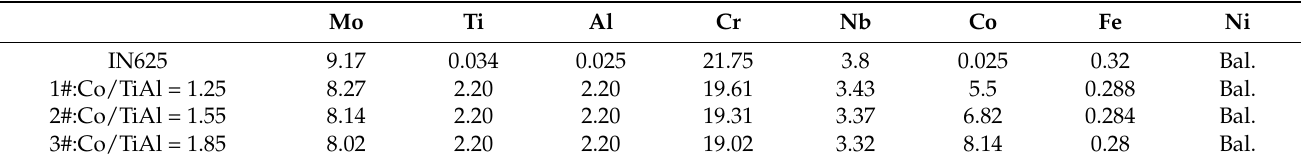
Table 1. Composition of laser-melted